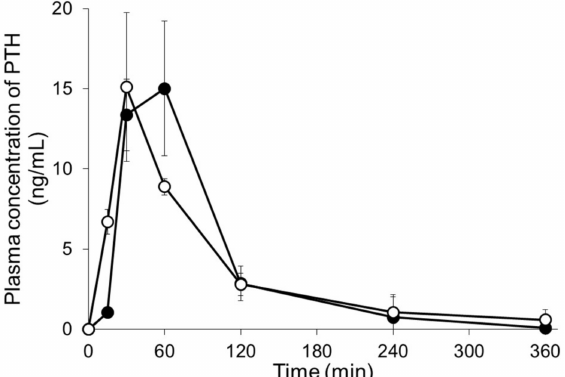
Figure 6. Plasma concentration-time profiles of human parathyroid hormone (1-34) (PTH) following either application of microneedle arrays (MNs) or subcutaneous injection. Keys: ( ) PTH-loaded MNs and ( ) subcutaneous injection of PTH. Results are expressed as the means ± standard deviation (SD) (cid:35) of three rats. Table 1. Pharmacokinetic parameters of human parathyroid hormone (PTH) after administration of PTH-loaded microneedle arrays (MNs) or subcutaneous injection of PTH. Dose ( µ g/rat)